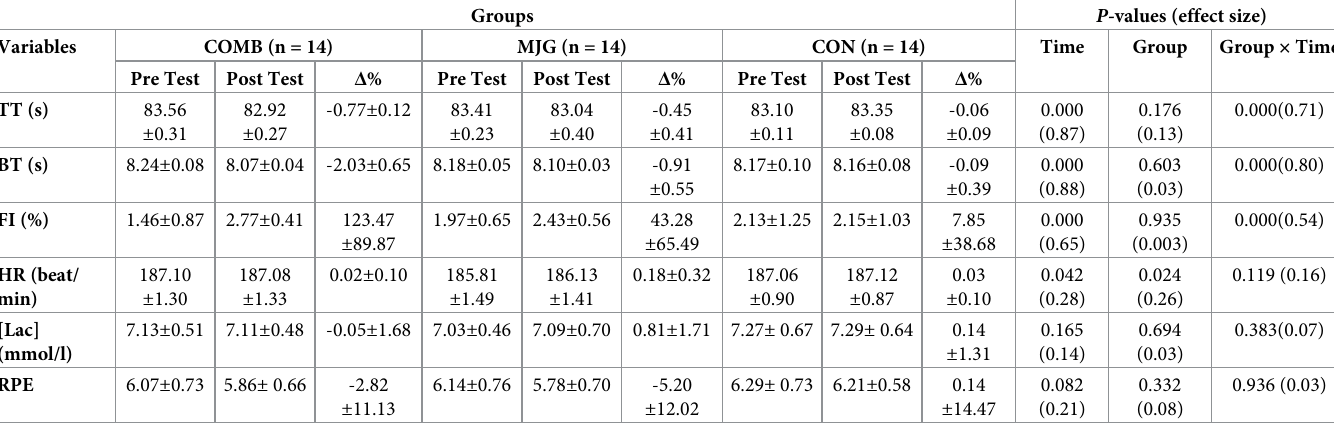
Table 4. Intensive repeated sprint ability test performances and physiological parameters determined before (pre-test) and after (post-test) the training program.